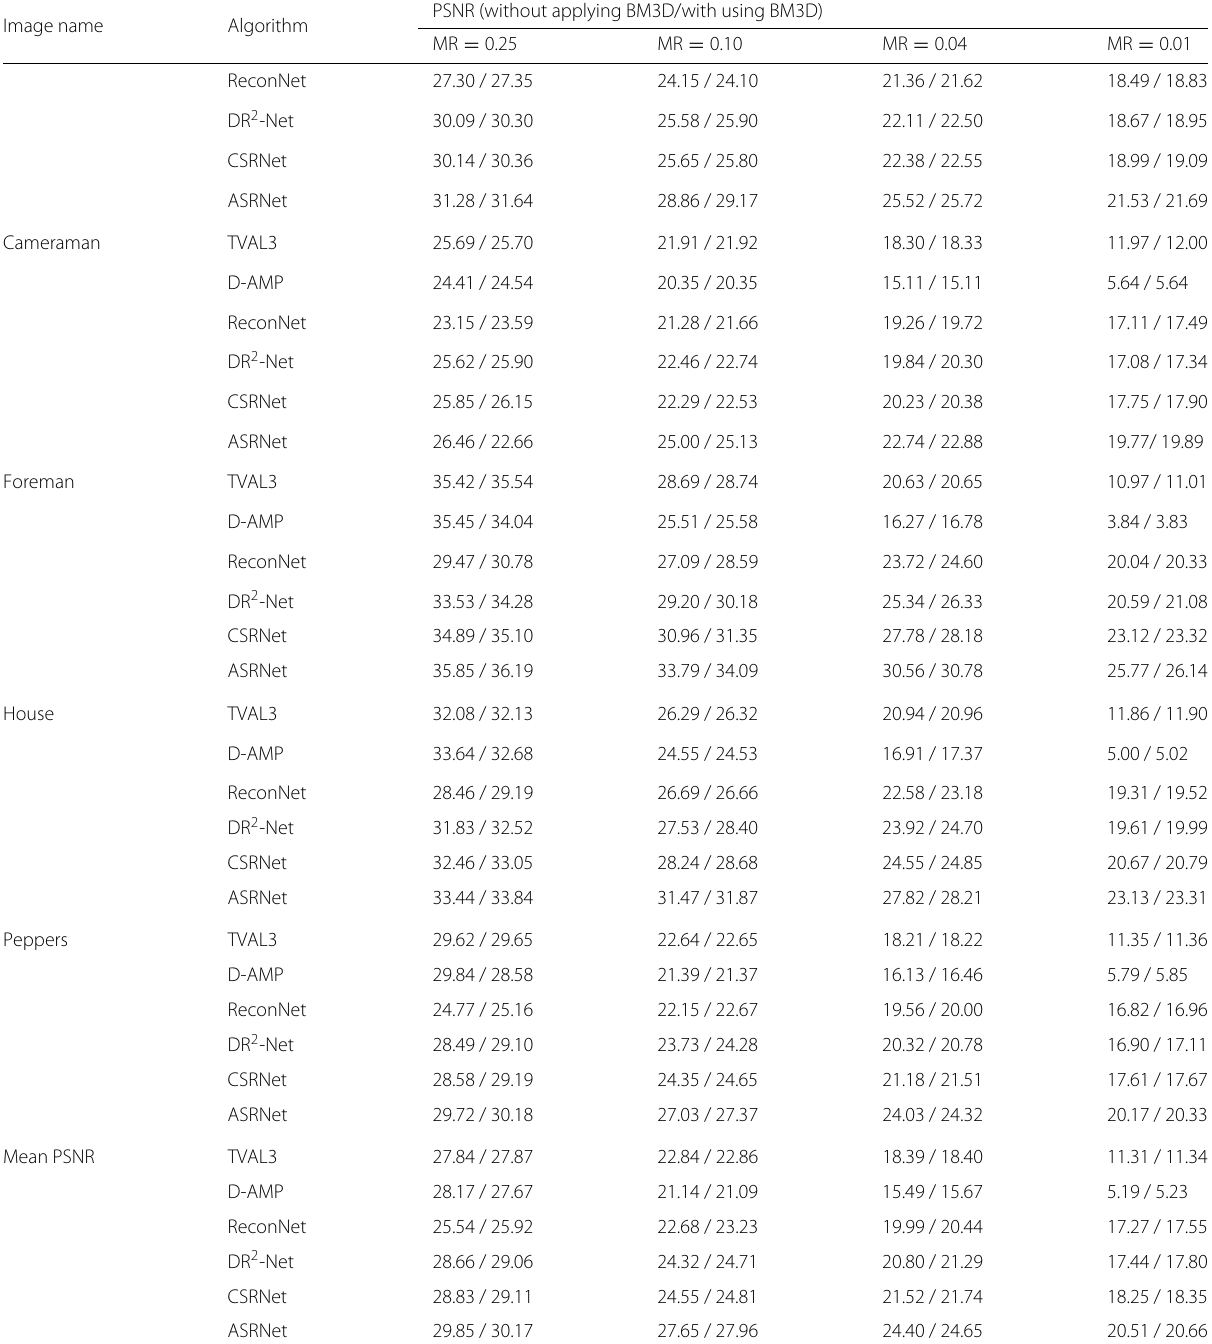
Table 1 PSNR valves in dB for testing image by different algorithms at the ratio MR = 0.25, 0.1, 0.04, and 0.01 ( Continued